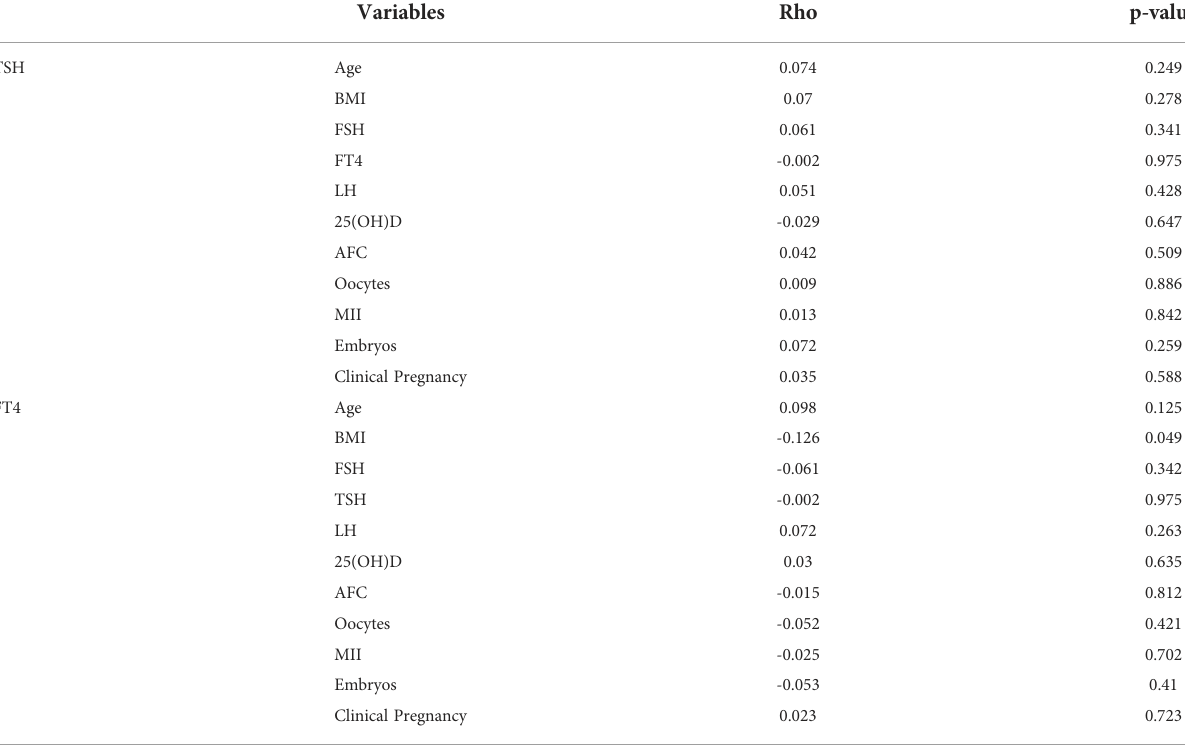
TABLE 3 Correlation of TSH and FT4, and factors associated to clinical pregnancy in euthyroid women undergoing